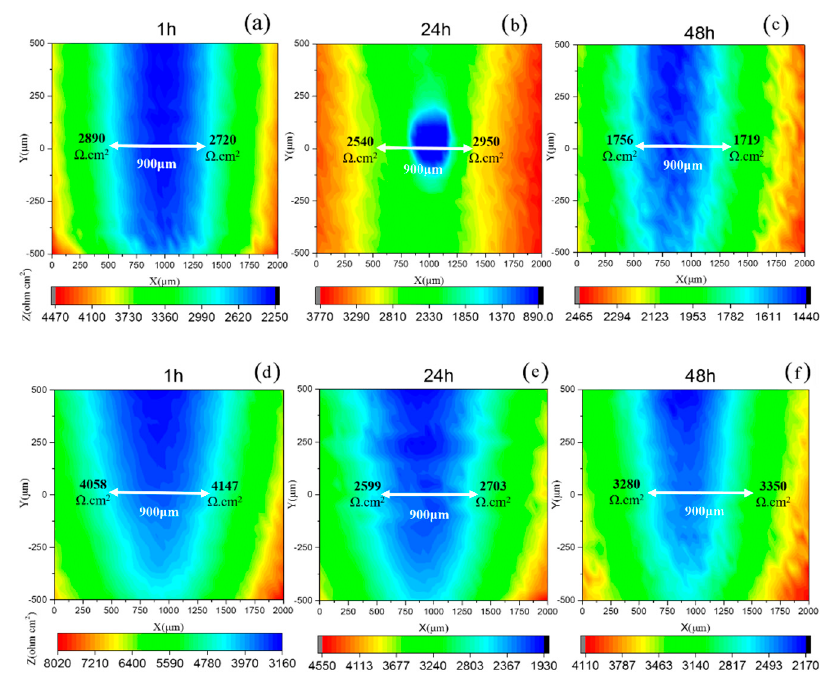
Figure 6. LEIS results for ( a – c ) ZRPs and ( d – f ) Gr0.6-ZRPs with an artificial scratch immersed in 0.005 M NaCl during 48 h.